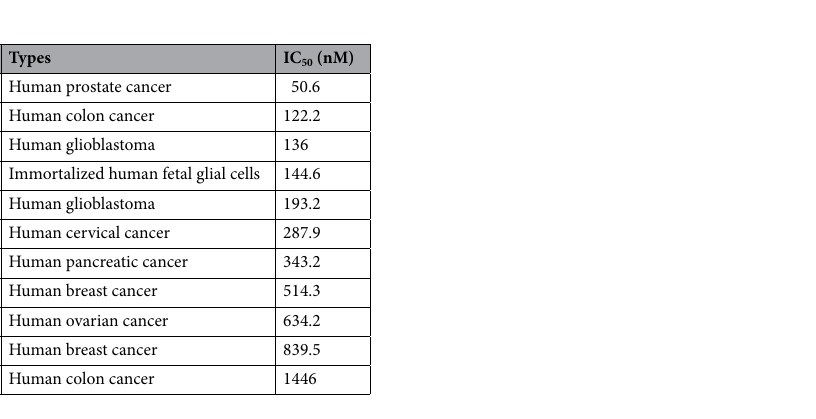
Table 3. IC 50 of EtGIPL1a against human cancer cell lines. MTT assays were performed 48 h after treatment with EtGIPL1a. The IC 50 the data shown is an average taken from two independent